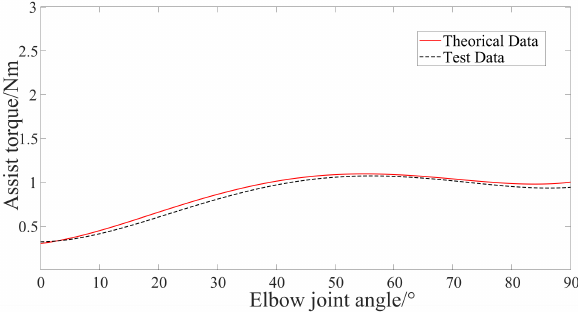
Figure 16. Exoskeleton assist torque control of elbow joint.